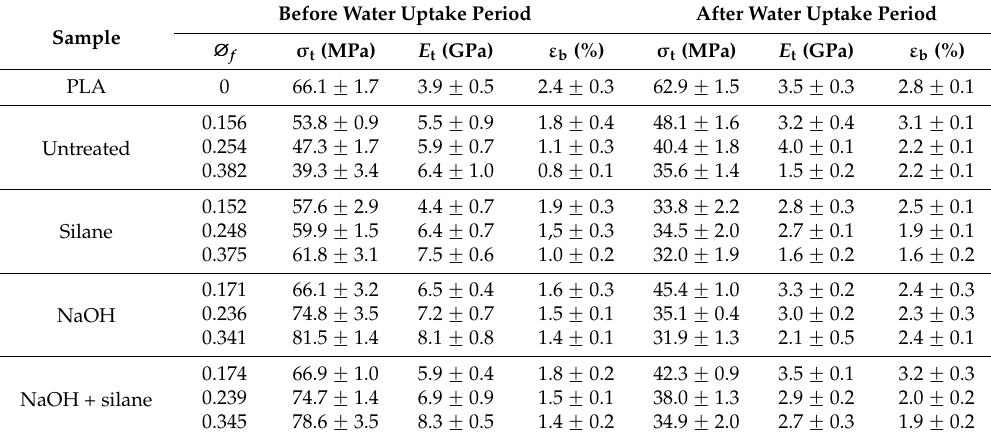
Table 2. Tensile properties of poly(lactic acid) matrix and composites based on sisal fibers before and after water uptake period.